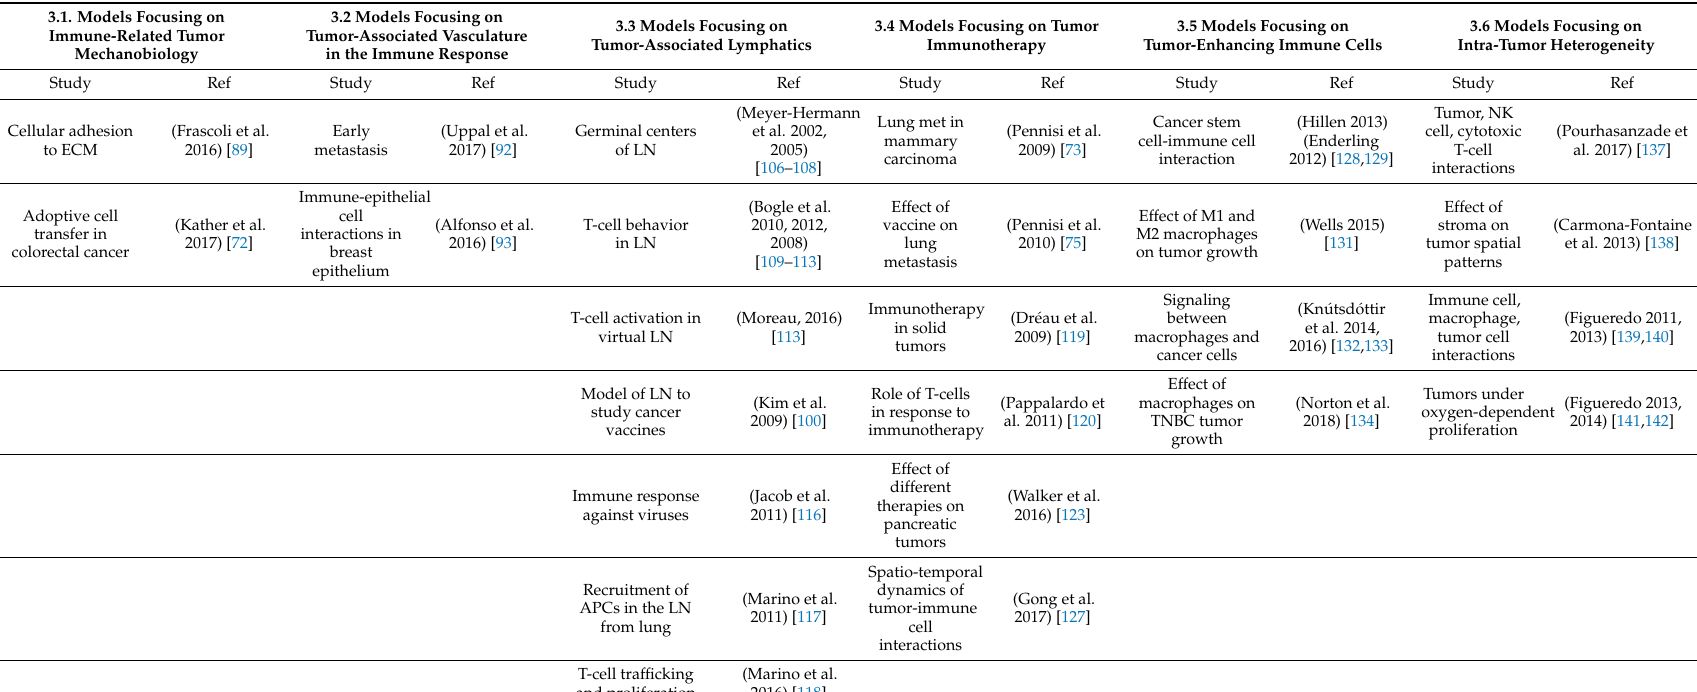
Table 1. Summary of Section 3: ABM and hybrid models discussed in each